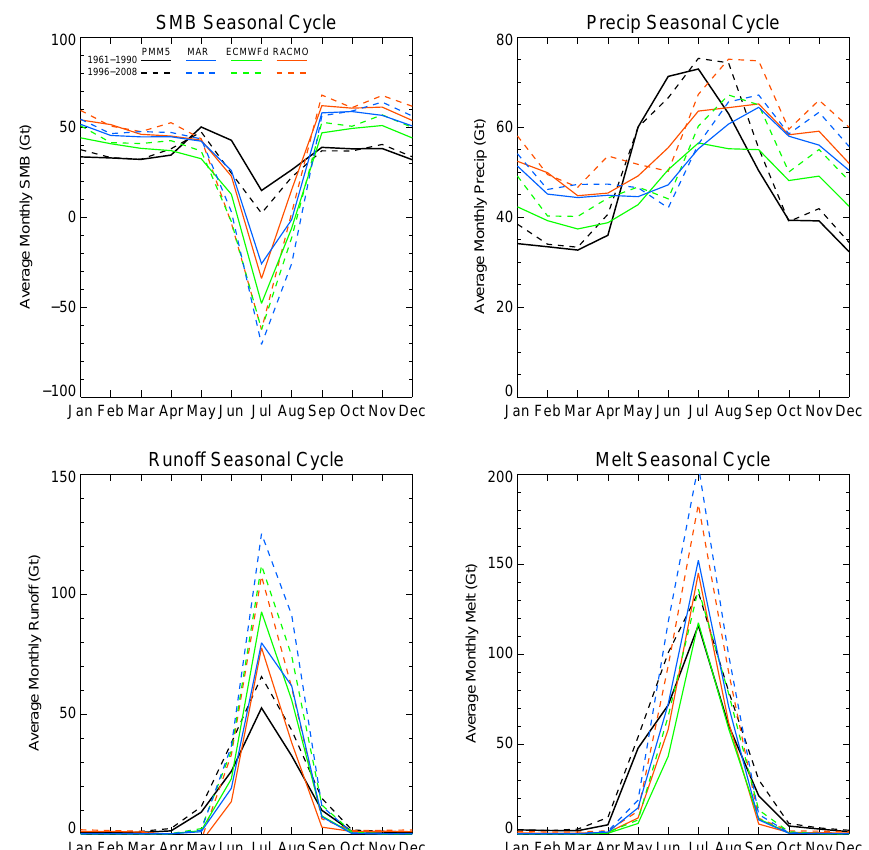
Fig. 9. Seasonal cycle of SMB, precipitation, runoff and melt for each model averaged over the 1961–1990 and 1996–2008 periods. In situ obs. and modelled SMB (K−transect)